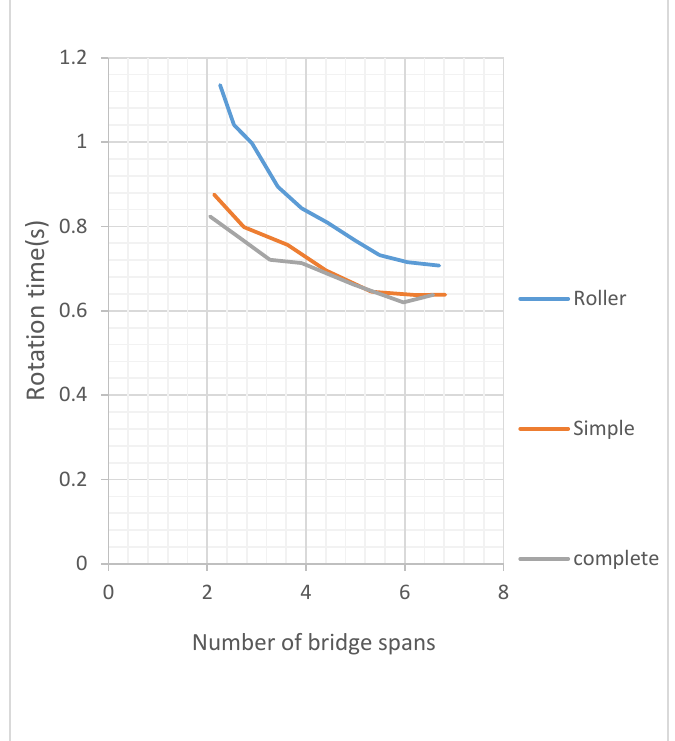
Fig. 14. The fundamental period of longitudinal vibration in bridges with a base height of 8